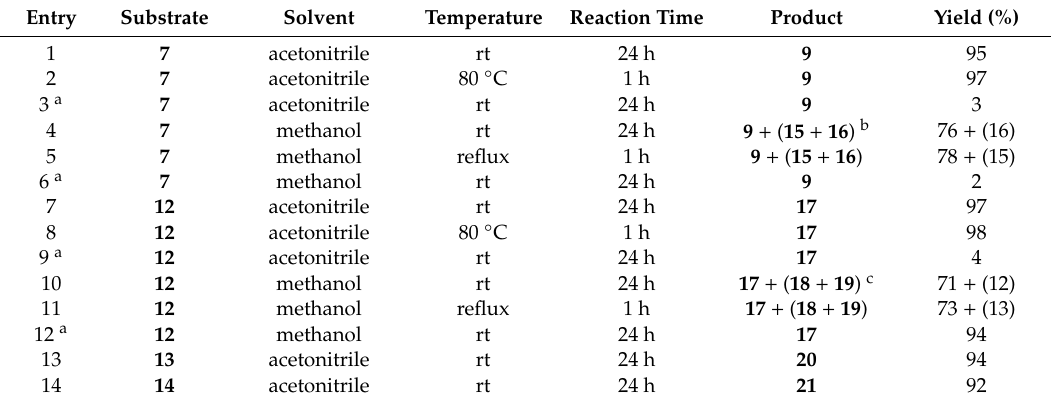
Table 1. Fluorinations of estrone ( 7 ), 13 α -estrone ( 12 ), 17-deoxyestrone ( 13 ) or 17-deoxy-13 α -estrone ( 14 ) with Selectfluor ( 2